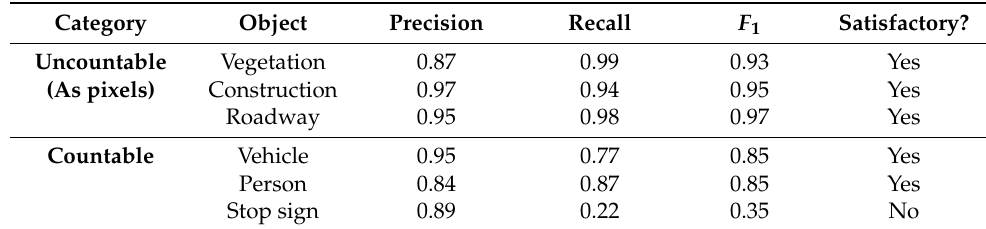
Table 2. Average validation results of the transductive deep transfer learning of Hong Kong TSV